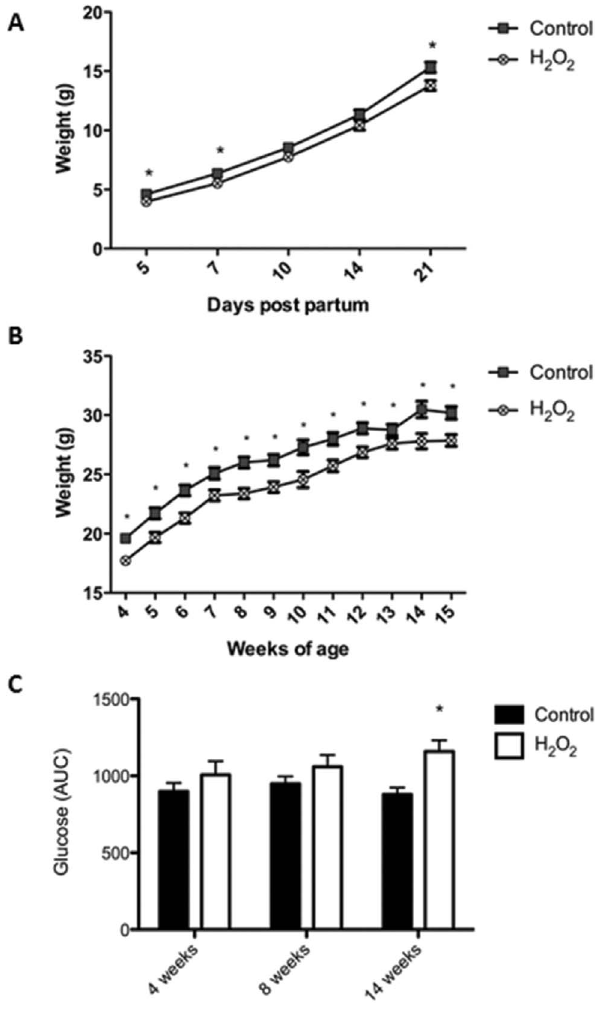
Figure 2. Effect of treatment of sperm with 1500 m M H 2 O 2 on female offspring weight gain and glucose tolerance. (A) pre- weaning weight, (B) post weaning weight, (C) glucose tolerance (AUC) Control female (n=7 from 6 litters), H 2 O 2 female (n=9 from 5 litters) representative of 15 stud CBAF1 males. Values are mean 6 SEM. * Indicates significantly different from control (P ,